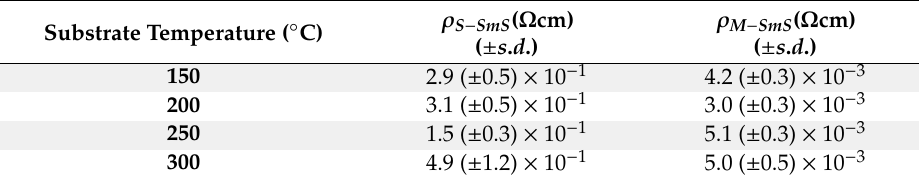
Table 1. Resistivity values of as-deposited and switched SmS thin films deposited at di ff erent substrate temperatures. The thin films were deposited at a rate of 0.8 nm / s and at an H 2 S pressure of 10 − 5 mbar. The values are the average of five di ff erent sheet resistance measurements of each sample, with the standard deviation between